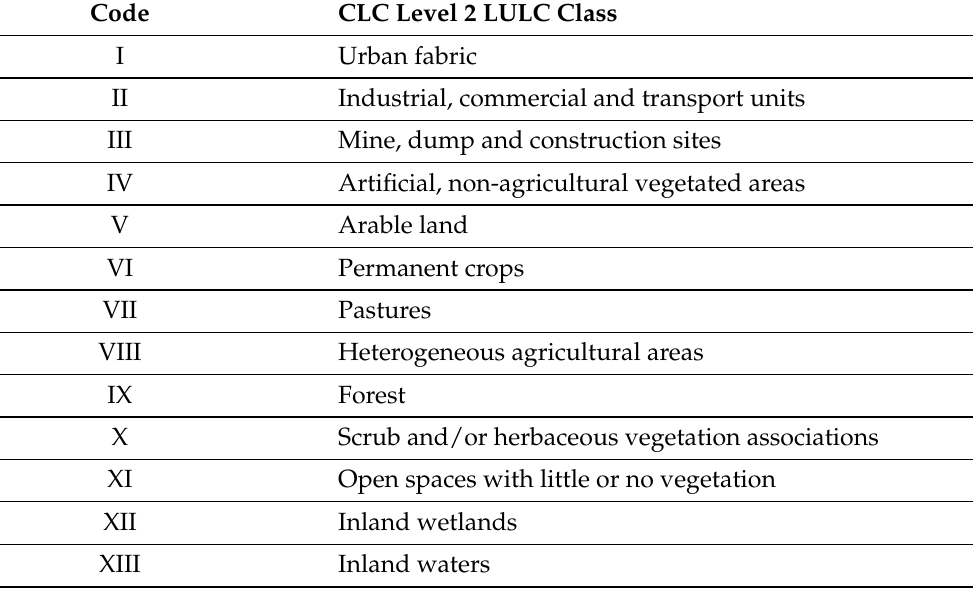
Table 1. The 13 different LULC available in the ROI (Austria). A total of 2 of the original 15 CORINE LULC Level 2 classes were not available as the ROI (Austria) is land-locked. These were Coastal wetlands and Marine waters